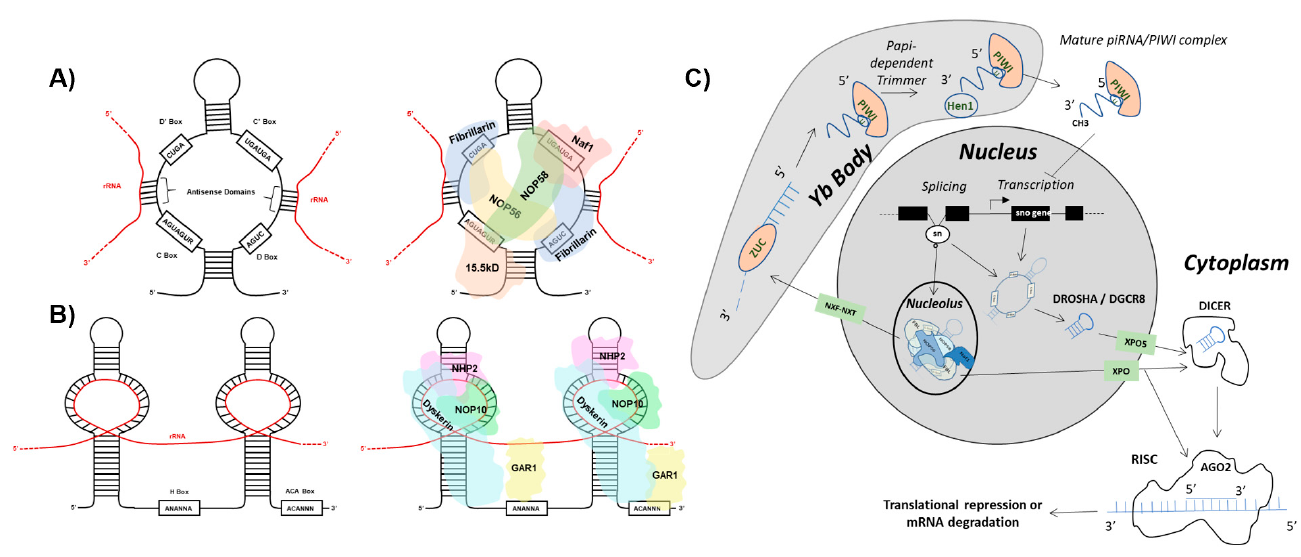
Figure 1. sdRNAs arise from full-length snoRNAs. ( A ) C/D box snoRNA structure and accessory proteins. ( Left ) The C/D box snoRNA consists of a 5 ′ C box (RUGAUGA) motif, a 3 ′ D box (CUGA) motif, and the C’ and D’ boxes located internally. Antisense domains identify target rRNAs (red) via complementarity. ( Right ) The C/D box snoRNP complex consists of NOP56, NOP58, 15.5 K, and fibrillarin proteins [4–6]. ( B ) H/ACA box snoRNA structure and accessory proteins. ( Left ) The H/ACA box snoRNA consists of a 3 ′ ACA box (ACANNN, N = any nt) and two hairpins that target rRNA (red) linked by an H box (ANANNA, N = any nt). ( Right ) The H/ACA box snoRNP complex consists of NHP2, NOP10, GAR1, and dyskerin proteins [7–9]. ( C ) sdRNA biogenesis and function. Biogenesis of Argonaute 2 (AGO2)-associating sno-derived RNAs (sdRNAs) Full length small-nucleolar RNAs (snoRNAs) are generated either as products of transcription or splicing [11–14]. snoRNAs produced by transcription can give rise to microRNA-like sdRNAs which are spe- cifically excised from parent snoRNA transcripts by employment of the classical microRNA (miRNA) processing pathway. This occurs by processing of parent snoRNAs into smaller tran- scripts by the microprocessor complex which consists of Drosha Ribonuclease III (DROSHA) and DiGeorge syndrome critical region 8 (DGCR8). The intermediate snoRNA then undergoes cyto- plasmic exportation via exportin 5 (XPO5). Following this, the smaller cytoplasmic snoRNA is processed by Dicer RNase III endonuclease (DICER) to generate the mature sdRNA which associ- ates with AGO2, leading to the formation of the RNA-induced Silencing Complex (RISC). Similar to miRNAs, these sdRNAs function in post-transcriptional gene suppression by antisense binding to target mRNA transcripts within RISC [15]. That said, snoRNAs produced by splicing can also enter the classical miRNA processing pathway. Spliced snoRNAs, however, can bypass processing from DROSHA/DGCR8 and/or DICER as a result of trafficking to the nucleolus and subsequent processing by the fibrillarin complex followed by cytoplasmic export via a transporter belonging to the Exportin (XPO) family of proteins [10]. Biogenesis of PIWI-associated RNA (piRNA) like sdRNAs Spliced snoRNAs which arrive at the nucleolus for fibrillarin processing can be trafficked into Yb bodies via Nuclear RNA Export Factor (NXF1)/ Nuclear Transport Factor 2 Like Export Factor 1 (NXT1) where the 3 ′ end is cleaved by Zucchini (ZUC) and subsequently degraded. The remaining transcript is processed further within the Yb body by the papi-dependent trimmer. Following this, HEN1 double-stranded RNA binding protein binds at the 3 ′ end of the transcript where it adds a methyl group, generating a mature piRNA/PIWI complex which is exported to the cytoplasm. This piRNA/PIWI complex can then be shuttled back into the nucleus where it func- tions to inhibit transcription [16,17].